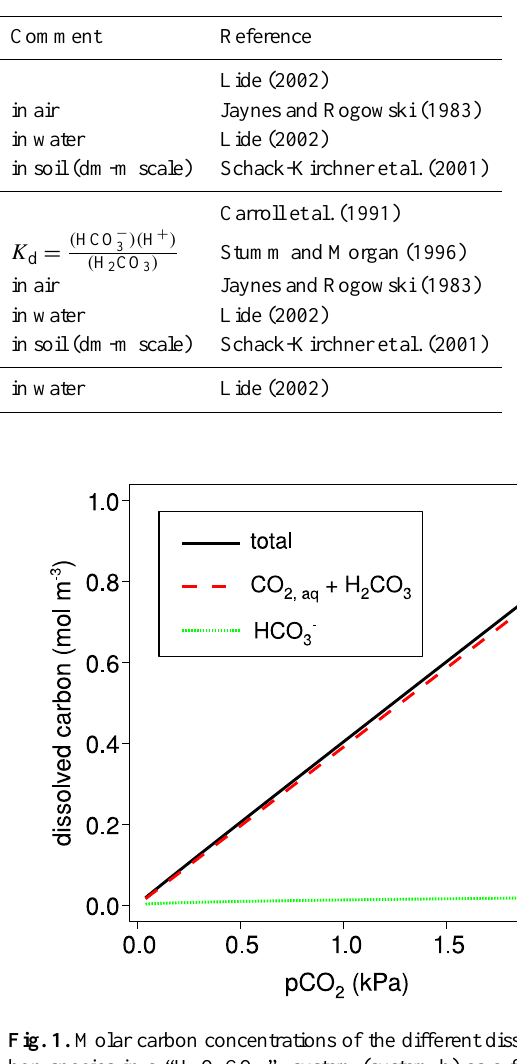
Table 1. Chemical constants and Fickian diffusion coefficients for O 2 , CO 2 , and HCO − dependence of the diffusion coefficients was calculated according to Tucker and Nelken (1990).